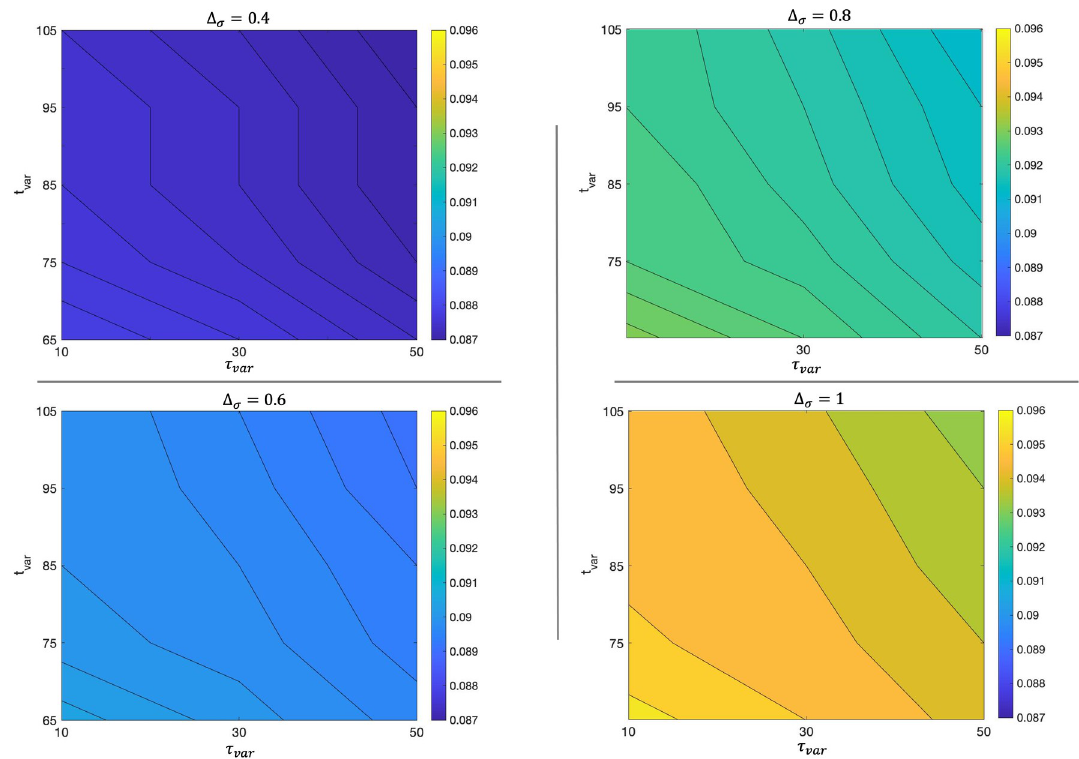
Fig 5. Total number of detected cases at the final day of simulation (December 16, 2021) for different values of the parameters Δ σ , τ var , t var